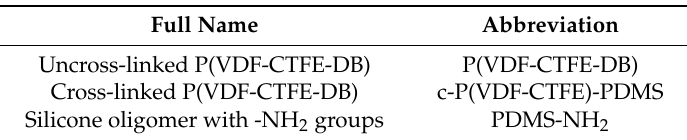
Table 1. Abbreviations for different materials.